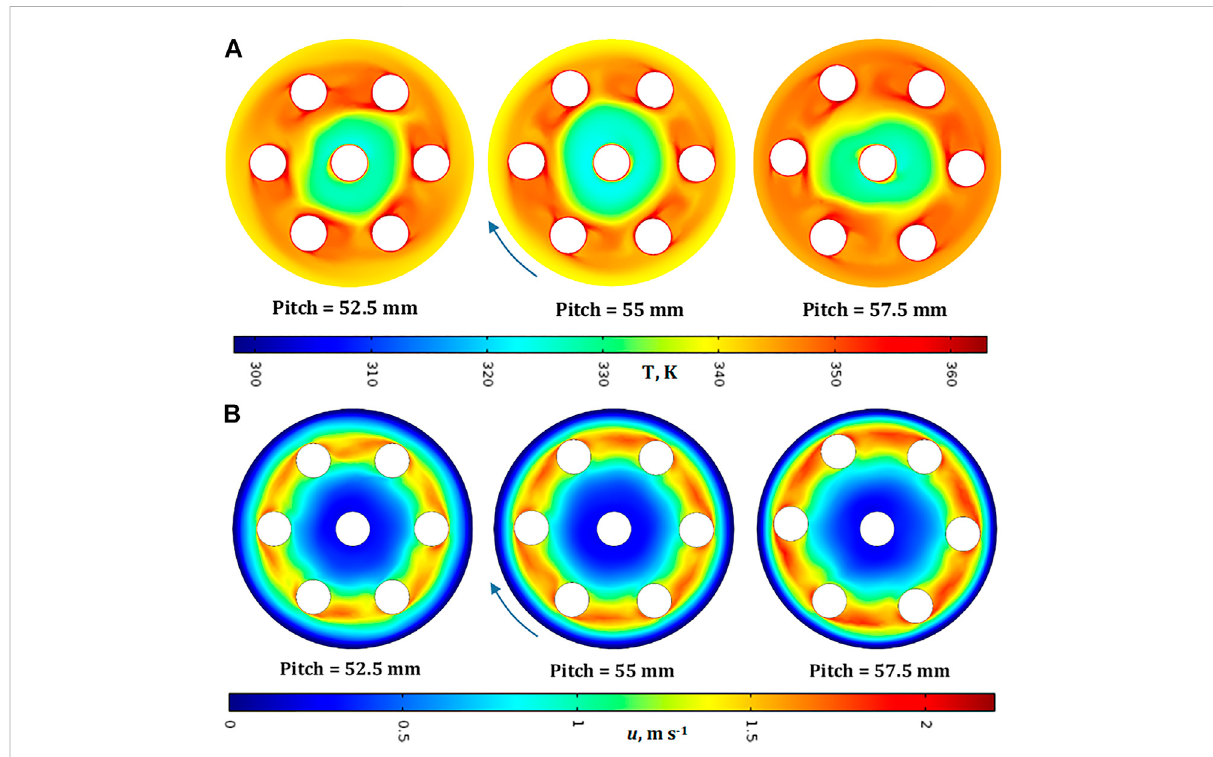
FIGURE 7 (A) Temperature and (B) velocity pro fi les at 5 s for different pitch values in adiabatic conditions in uniform con fi guration. Fluid: water, T spot = 90 ° C, T ext = 25 °